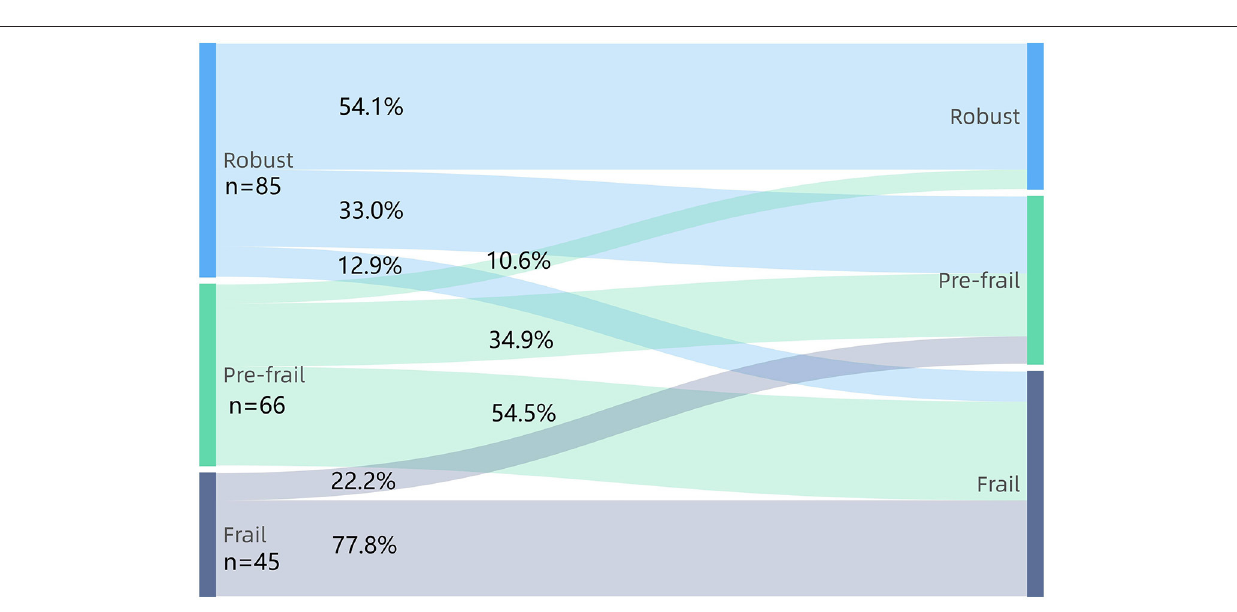
FIGURE 2 | The frailty status transitions between baseline and 2-year